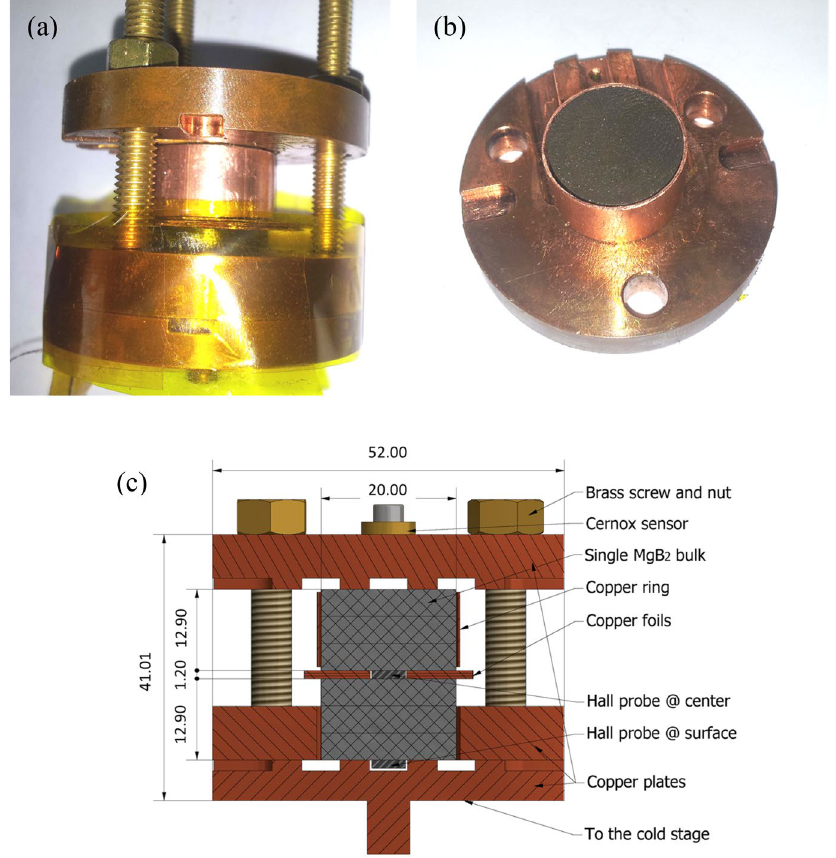
Figure 1. ( a ) Sample stage for trapped magnetic field measurement; ( b ) Copper ring with a diameter of 20 mm in which are introduced the MgB 2 superconducting discs for a rigid assembly into the compound column-magnet stack; ( c ) Schematic drawing (cross-section) of the six discs mounted in the sample holder. All dimensions are in